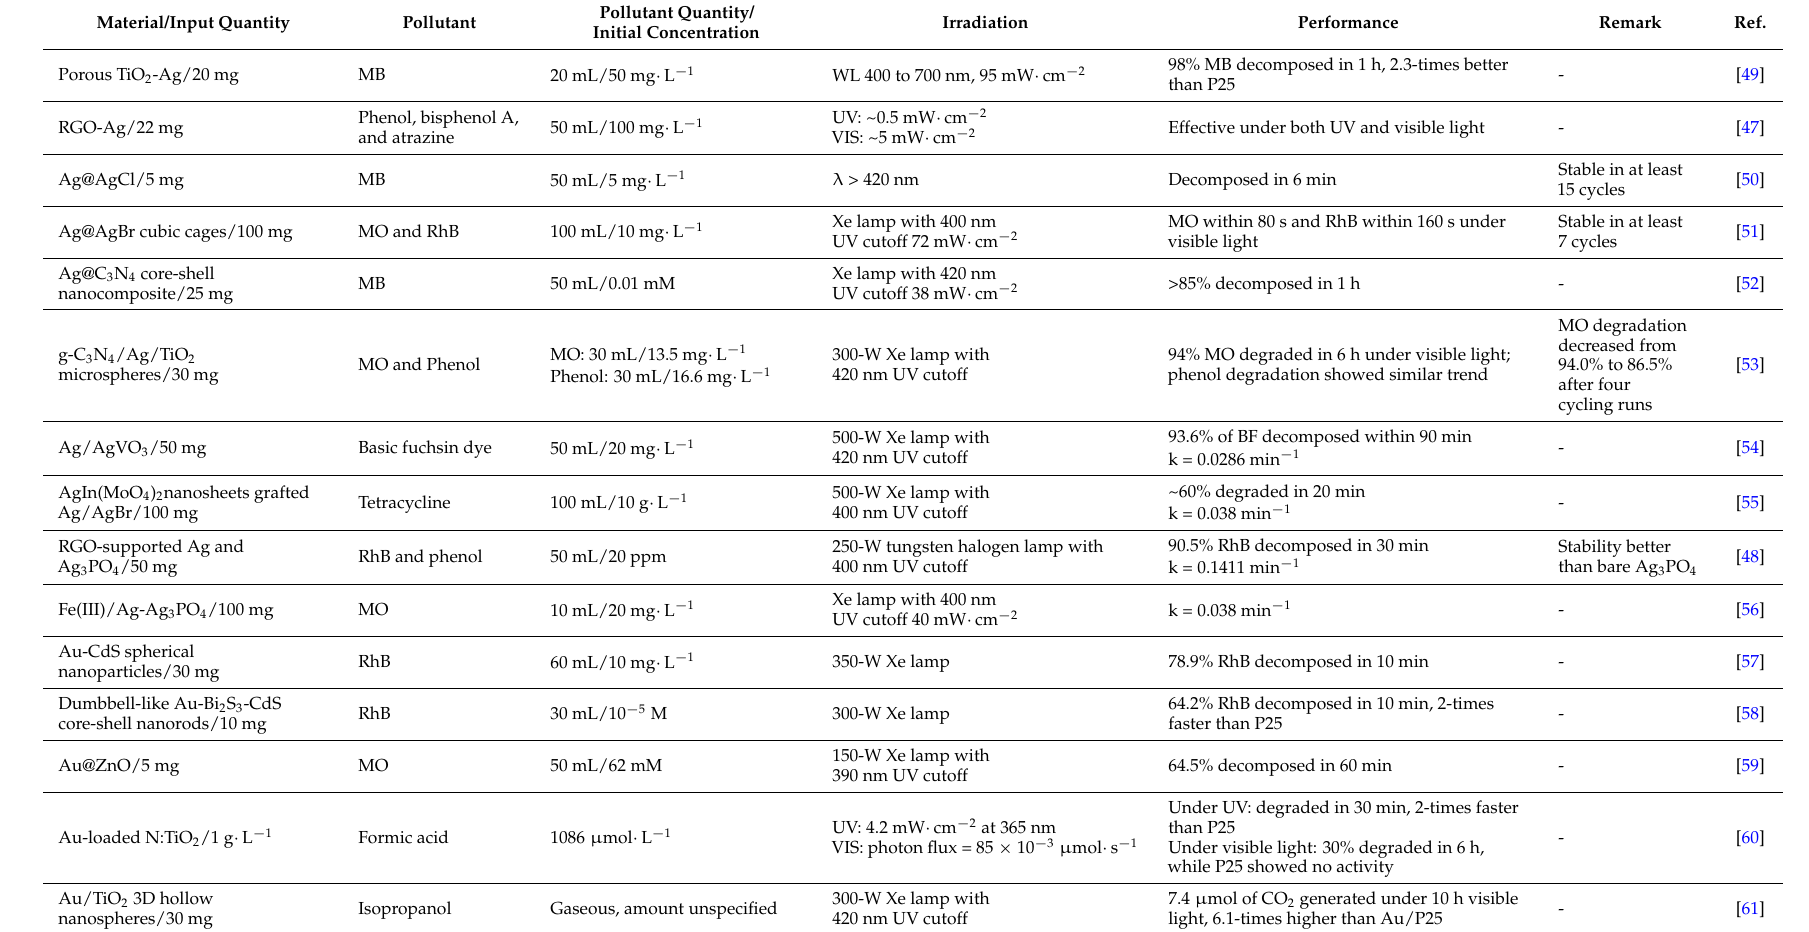
Table 1. Plasmonic photocatalytic chemical